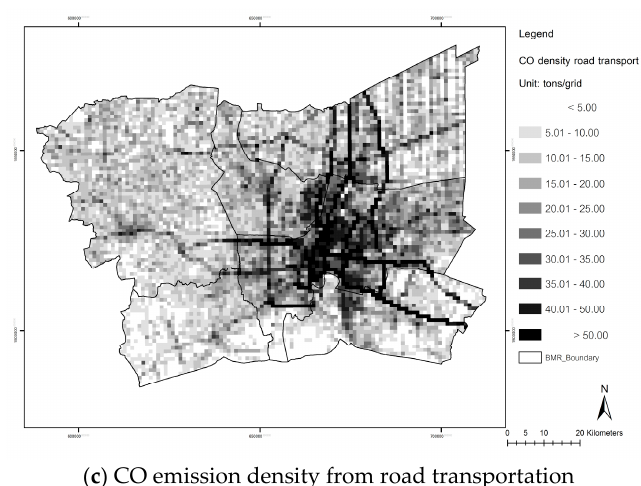
Figure 14. Spatial allocation of CO emission in the BMR, 2015: ( a ) light duty vehicles and motorcycles; ( b ) heavy duty vehicles; ( c ) road transportation.